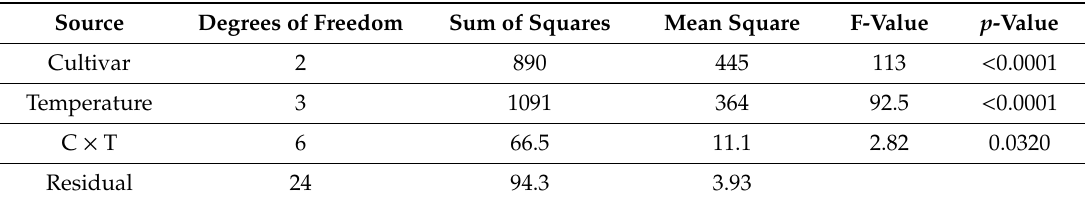
Table A2. Analysis of variance for photosynthetic rates measured at 500 µ mol mol − 1 C i for three soybean cultivars grown at 15 ◦ C.